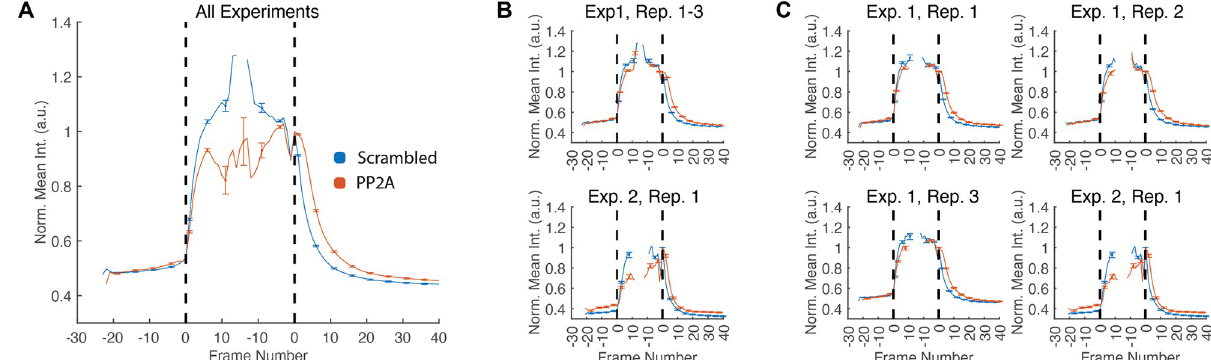
Fig 3. Grouped data visualizations. The three panels illustrate the different grouped visualization possibilities and were obtained using four experiments showing the normalized mean intensity for two oligos (Scrambled, PP2A). Exp. 1, Rep. 1–3 are three repetitions of the same experiment and Exp. 2, Rep. 1 is one separate experiment that was acquired using a different modality (confocal instead of a widefield microscope). The settings for combining the experiments (from left to right) are: (A) average time series of all experiments and repeats, (B) time series averaged over the repeats with separate plots per experiment and (C) individual plots for all experiments and repeats. Error bars indicate one standard deviation and the vertical bars represent the IP and the MA transitions.